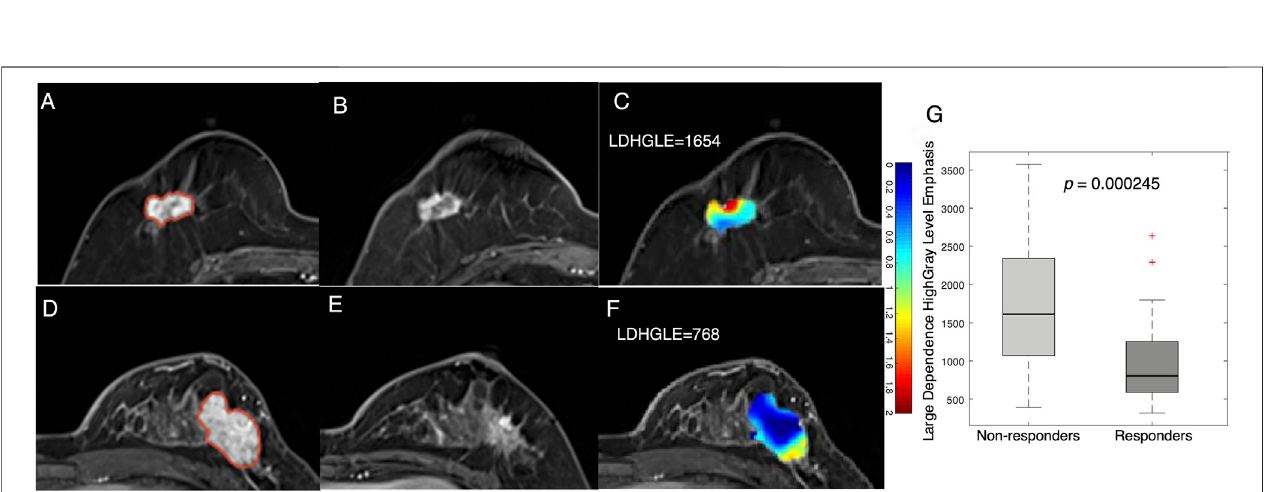
FIGURE3| Exampleimagesand distribution ofmeanJacobianvaluesinnonrespondersandresponders.Imagesfromabreastcancerpatient(aged45 yearsold) with a low MP (nonresponder) (A) pre- and (B) post-treatment and (C) a Jacobian map of the ROI (mean Jacobian value (cid:1) 0.746). Images from a breast cancer patient (aged 41 years old) with a high MP (responder) (D) pre- and (E) post-treatment and (F) a Jacobian map of the ROI (mean Jacobian value (cid:1) 0.449). (G) Boxplot representing the feature distribution between nonresponders and responders.